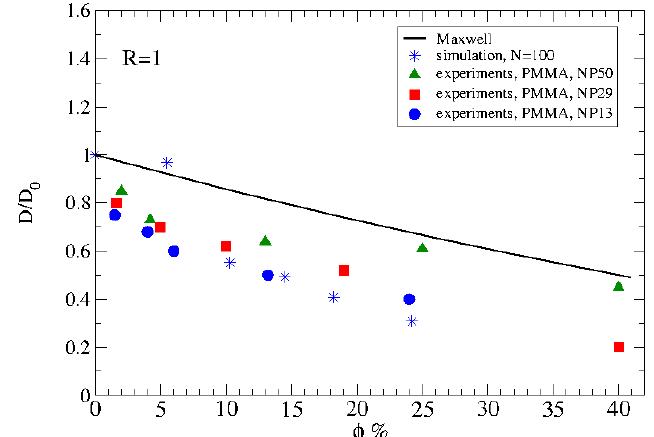
Figure 8. Dependence of diffusivity (normalized to its bulk value) of mildly entangled polymers ( N = 100) for different nanoparticle loading:(i) Maxwell prediction (black line) (ii) simulation data N = 100 (stars), (iii) PMMA tracer diffusion: diameter d NP = 13 nm (circles), (iv) d NP = 29 nm (squares), (v) d NP = 50 nm (triangles). Reprinted from [119] with permission from